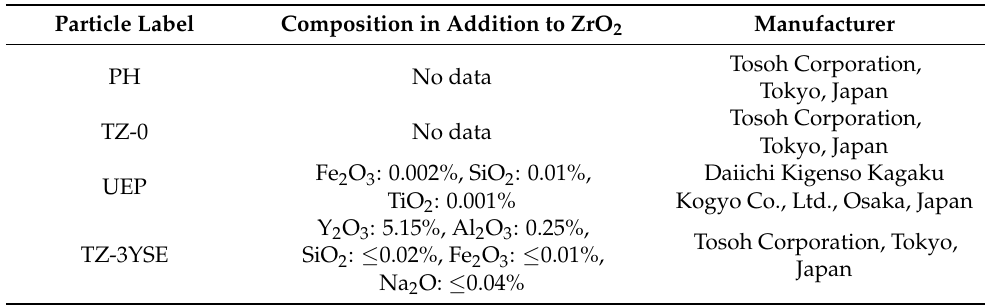
Table 1. Nomenclature and composition of zirconia particles used for ToF-SIMS analysis and cell culture experiments. Data provided by